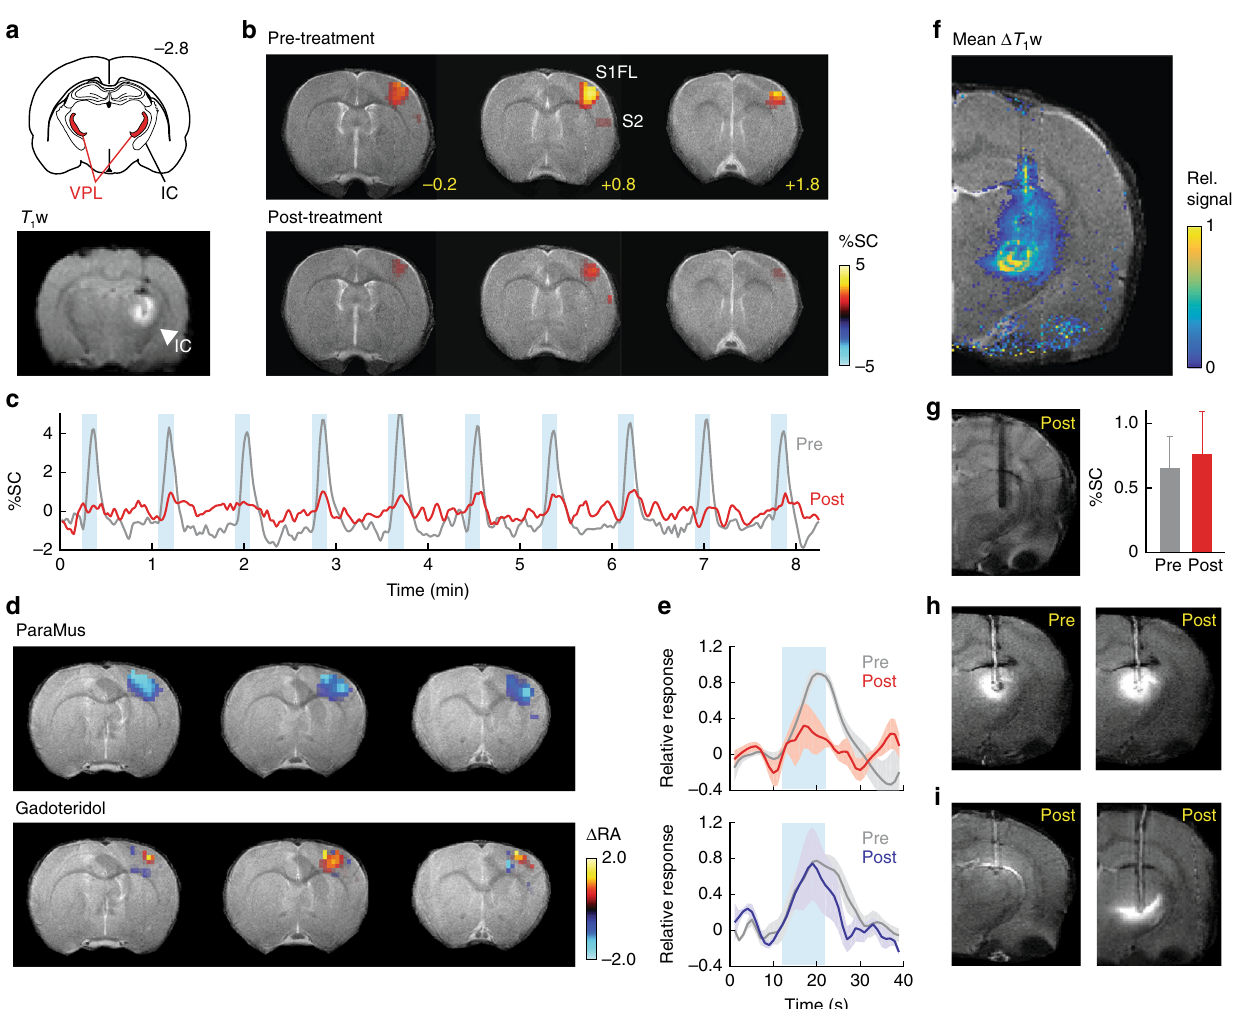
Fig. 2 Image-guided manipulation of somatosensory responses in the rat brain. a Top: Coronal brain schematic 12 at bregma = – 2.8 mm, showing the location of VPL (red) bordered on the lateral side by the internal capsule (IC). Bottom: a corresponding T 1 -weighted ( T 1 w) coronal image showing contrast enhancement in the VPL region following ParaMus infusion. Hypointense white matter IC signal denoted by arrowhead. b Forepaw stimulation-induced fMRI responses, in units of percent signal change (%SC), in a single animal before (top) and after (bottom) the ParaMus infusion shown in a . S1FL and S2 regions labeled; bregma coordinates in yellow. c Time course of fMRI signal in the S1FL region pre- (gray) and post-infusion (red), corresponding to data in b ; stimulation blocks denoted by blue rectangles. d Change in fMRI response amplitudes ( Δ RA), relative to pretreatment responses, after VPL-targeted ParaMus infusion (top, n = 5) or control infusion with gadoteridol (bottom, n = 4). e Mean relative peristimulus response time courses associated with the maps in d , pre- and post-treatment with ParaMus (top) or gadoteridol (bottom). Shading denotes SEM over fi ve animals (top) or four animals (bottom). f Pro fi le of mean relative T 1 -weighted MRI signal changes following ParaMus infusion in fi ve animals. Control infusions lacking contrast agent produced no notable contrast enhancement. g A failed ParaMus infusion results in no enhancement in the posttreatment condition (left). Correspondingly, there is no decrease in fMRI response to forepaw stimulation after treatment (right); error bars denote SEM of responses over 10 stimulus cycles in a single animal. h Premature infusion of ParaMus is easily detectable by comparing pre- and post-treatment T 1 -weighted images. i Anomalous spatial distributions of ParaMus are recognized in images of two separate animals in the postinfusion